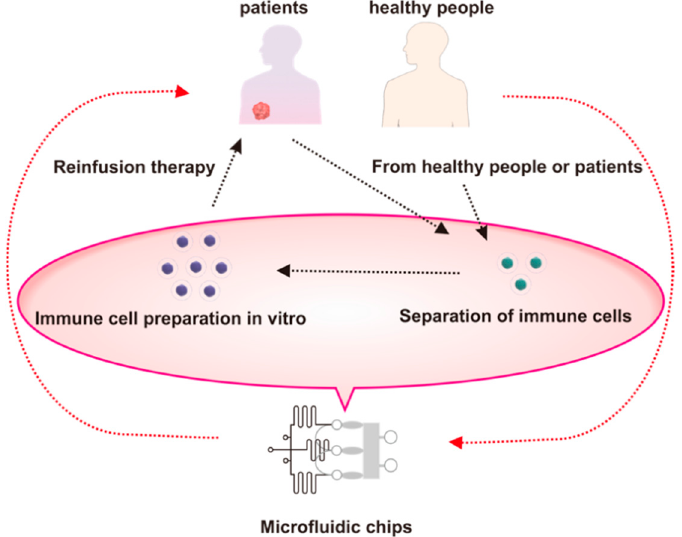
Table 1. Summary of cell isolation